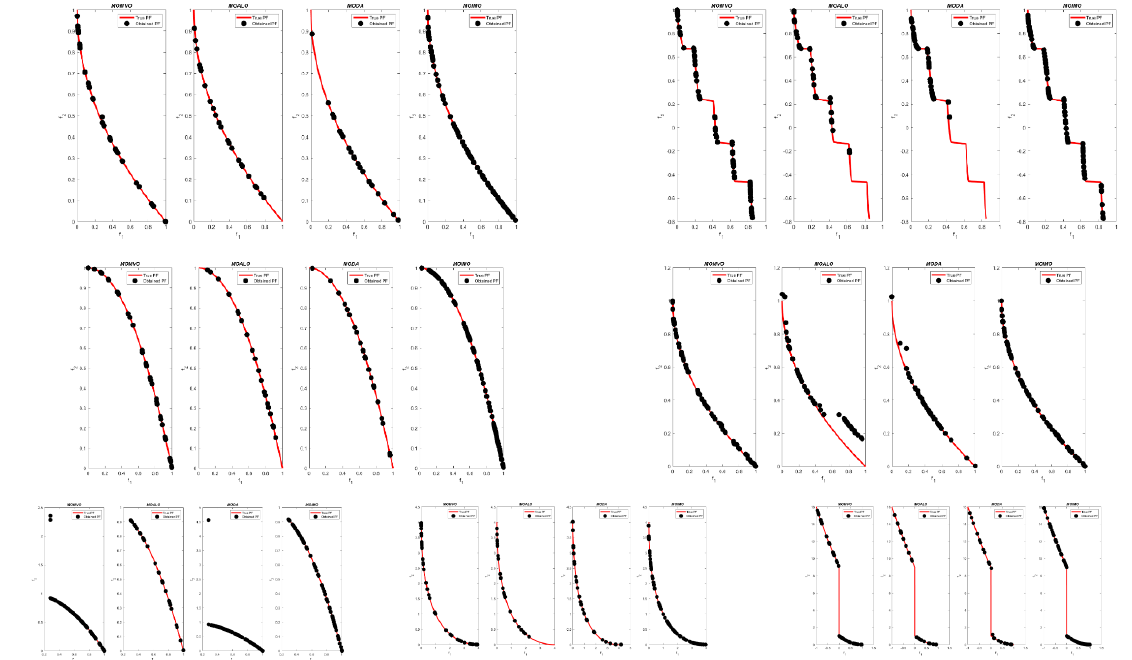
Fig. 6. Best Pareto front for unconstrained benchmark